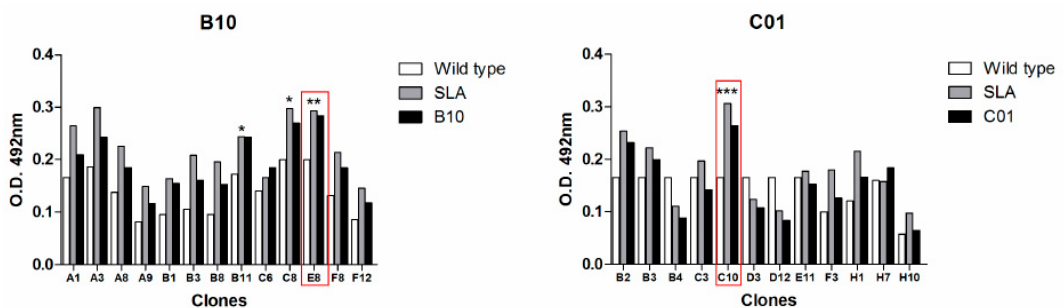
Figure 2. ELISA screening to identify the specific scFv antibody fragments. Three ELISA’ from each clone were performed. The scFv clones were reacted against B10 and C01 phages, L. infantum SLA and wild-type phage. The scFv-E8 and scFv-C10 clones showed higher reactivity to B10 and C01 phages, respectively. The scFv-E8 and scFv-C10 clones were selected due to the best absorbance ratio between the target and the controls, demonstrating better antibody specificity and a most significant p -value (* p < 0.05; ** p < 0.01, and *** p < 0.005). The x-axis have the clones effectively secreted anti-B10 or C01 and on the y-axis shown the absorbance (492) nm of the samples in ELISA.